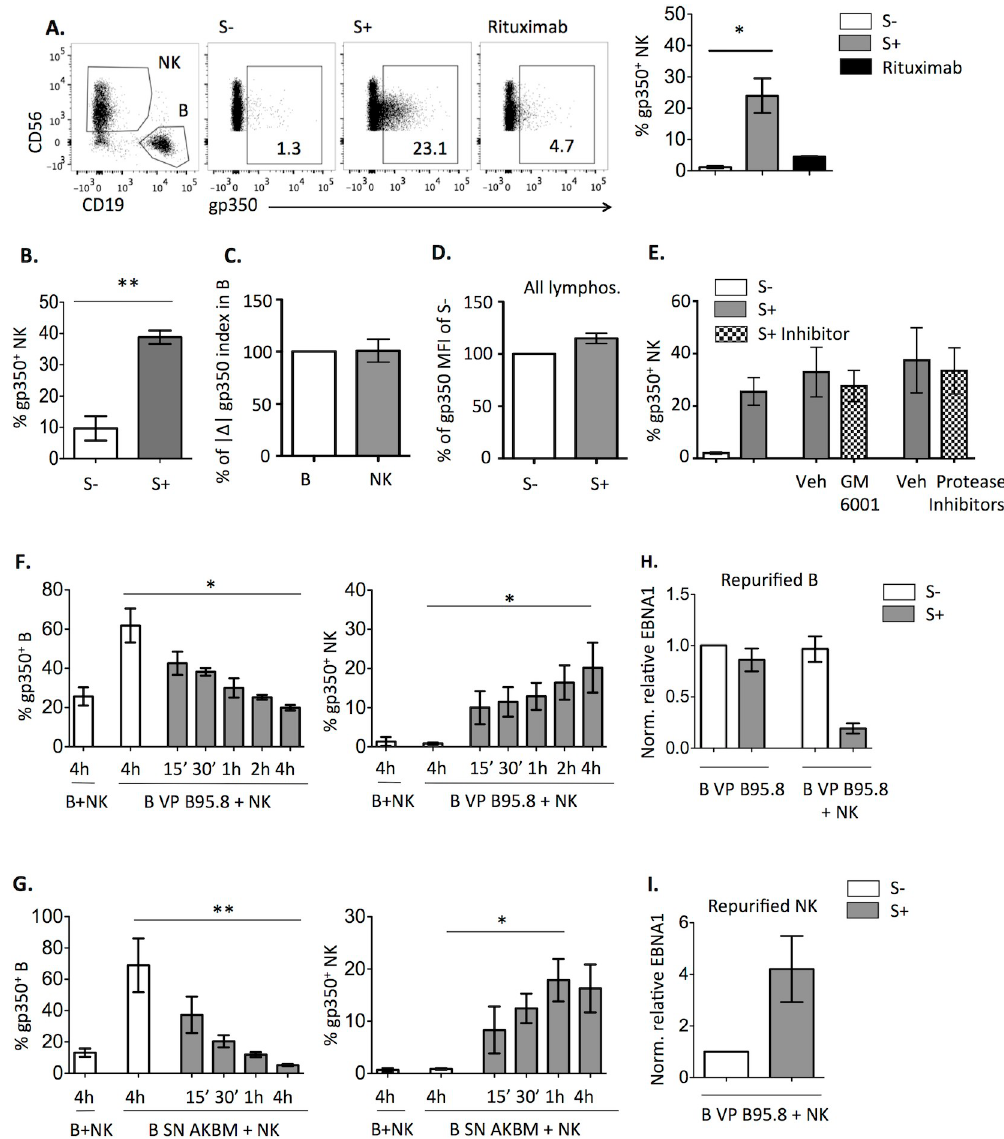
Fig 4. EBV S+ induces VP transfer from B to NK cells. (A) B cells were coated with B95.8 VP, stained for gp350 and incubated for 4h with NK cells in the presence of EBV S-, S+ serum or 25ng/ml of Rituximab. Proportions of gp350 + NK cells detected in representative plots (left) or four experiments (right) are shown. Statistical analysis with Friedman test and Dunn’s post-test was applied. ( B) B cells were incubated with AKBM SN, stained for gp350, co-cultured for 4h with NK cells in the presence of sera from various EBV S- (n = 5) or S+ (n = 6) donors, and analyzed for the proportions of gp350 + NK cells. ( C - D) B cells were treated and co-cultured with NK cells as in ( A ), in the presence of EBV S- or S+ sera. ( C) A gp350 fluorescence index was calculated for B and NK cells multiplying the percentage of the population by the corresponding gp350 MFI; the absolute variation (| Δ |) of the index comparing conditions with EBV S- and S+ was calculated. For each experiment, the absolute variation of the index in NK cells was expressed as a percentage of that calculated for B cells. ( D) For each experiment, MFI of all live cells in the co-culture with EBV S+ was expressed as a percentage of that calculated for EBV S- co- cultures. In C - D results of eight experiments are shown . (E-G) B cells were incubated with B95.8 VP ( E, F ) or AKBM VP ( G ), stained for gp350 and co-cultured with NK cells, in the presence of EBV S- or S+ for 4h ( E ) or during the indicated times ( F , G ). The proportions of gp350 + B ( F , G ; left) and NK cells ( E - G , right) corresponding respectively to four ( E ) and three ( F, G ) experiments are shown. Statistical analysis was performed with Friedman test with Dunn’s post-test. ( H - I) B cells coated with B95.8 VP were cultured alone or with NK cells in the presence of EBV S- or S+ serum for 4h, followed by separation of B and NK cells. DNA was extracted from both cell fractions and analyzed by qPCR for the EBV gene EBNA1 and the endogenous gene 36B4. Relative quantification of EBNA1 in relation to 36B4 for B ( H ) and NK cells ( I ) was calculated and normalized to the first condition of each graph. Data correspond to three experiments.